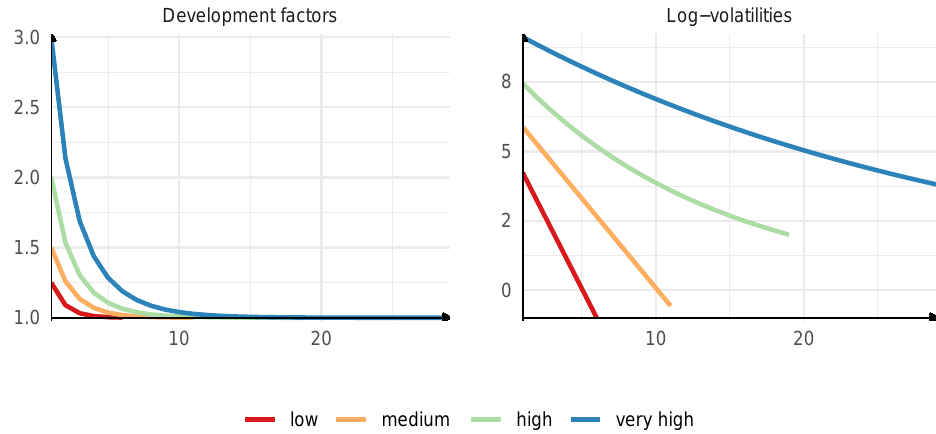
Figure A1. Parameters f j and log ( σ j ) used in the simulation